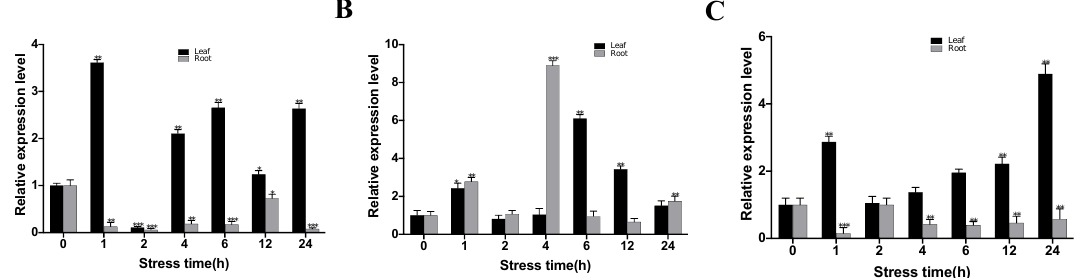
Figure 3. ( A ). Expression pattern of CgbZIP1 under salt stress. ( B ). Expression pattern of CgbZIP1 under PEG drought stress. ( C ). Expression pattern of CgbZIP1 under ABA stress. Error bars represent SE. Asterisks (*, ** or ***) indicate a significant difference of relative expression level between different stress time points and controls at p < 0.05, 0.01, or 0.001, respectively, by the Student’s t -test. Under drought stress simulated by PEG treatment, CgbZIP1 was upregulated 1h after and then gradually went down but remained higher than the control 24 h after